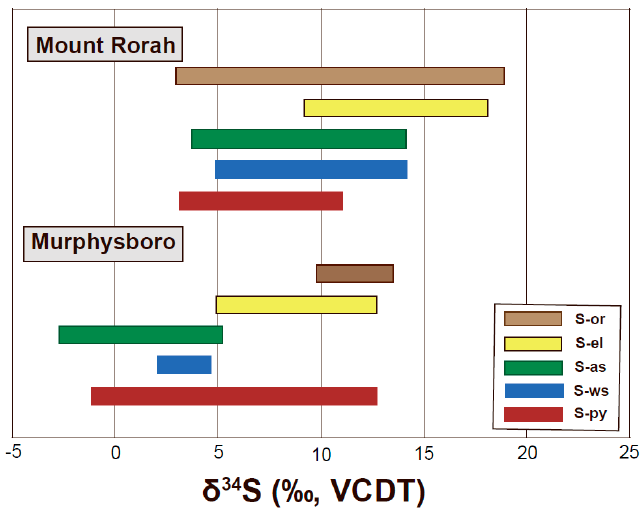
Figure 8. Range of sulfur isotopes values of sulfur fractions from Murphysboro and Mt. Rorah coal samples: organic sulfur (S-or), elemental sulfur (S-el), acid-soluble sulfur (S-as), water-soluble sulfur (S-ws) and pyritic sulfur (S-py). Data S-py are tabulated in Appendix A1 and previously published data for S-or, S-el, S-as, and S-ws are from Singh [48].